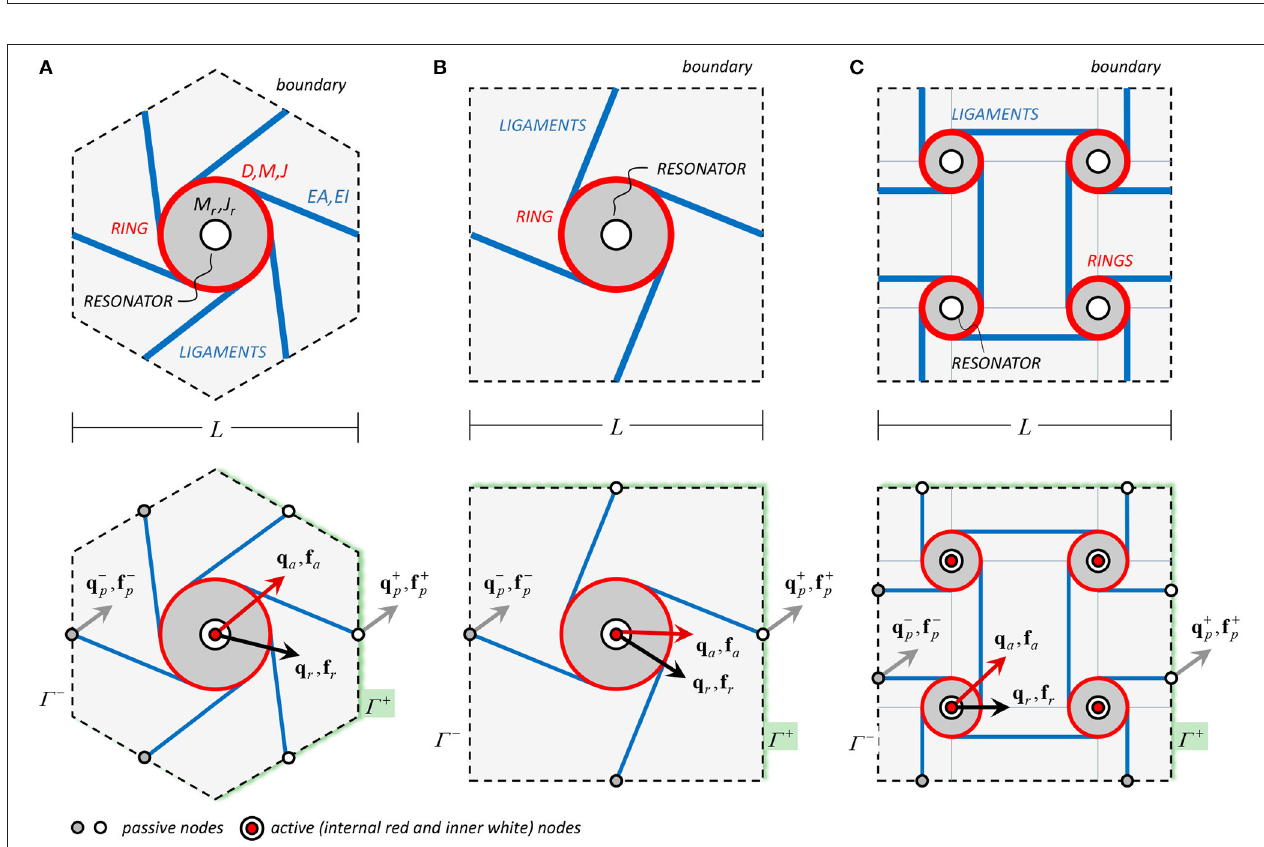
displacement v i and the in-plane rotation φ i . All the non- dimensional configuration variables can be collected in the 3 N - by-one displacement column-vector q = ( q 1 , ..., q i , ..., q N ), where the i -th nodal subvector is q i = ( u i , v i , φ i ).